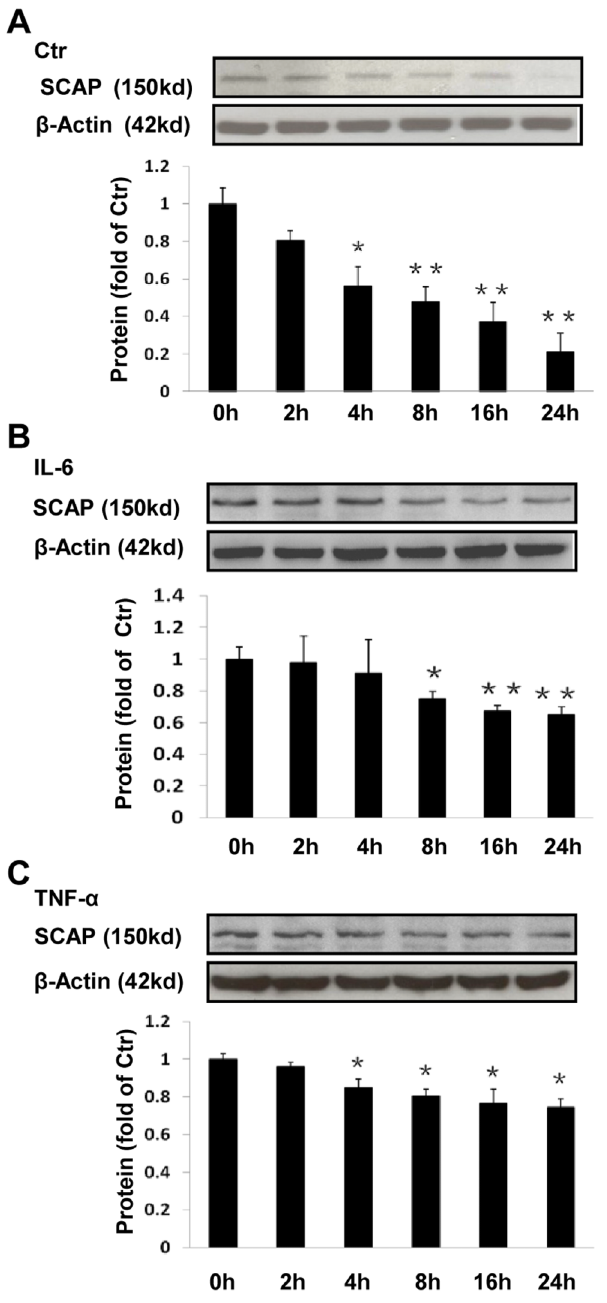
Figure 6. Effects of inflammation on SCAP stability in THP-1 macrophages. The cells were treated with or without 40 ng/ml IL-6 or 50 ng/ml TNF- a for 24 h, and then chased in the presence of 50 m mol/l CHX for 0, 2, 4, 8, 16 and 24 h. The cells were lysed in equal volumes of buffer and protein levels plotted as a percentage of the SCAP remaining compared with the amount at 0 h. The histogram represents mean 6 SD of the densitometric scans of SCAP protein bands from 4 experiments, normalized to b - Actin and expressed as a percentage of control. * P , 0.05 vs 0 h; ** P , 0.01 vs 0 h. doi:10.1371/journal.pone.0075650.g006 Glycosylation is a frequent post-translational modification of proteins which modulates a variety of biological functions [22,32]. Two Golgi enzymes ( a -mannosidase I and a -mannosidase II) are considered responsible for SCAP glycosylation [15]. The a -